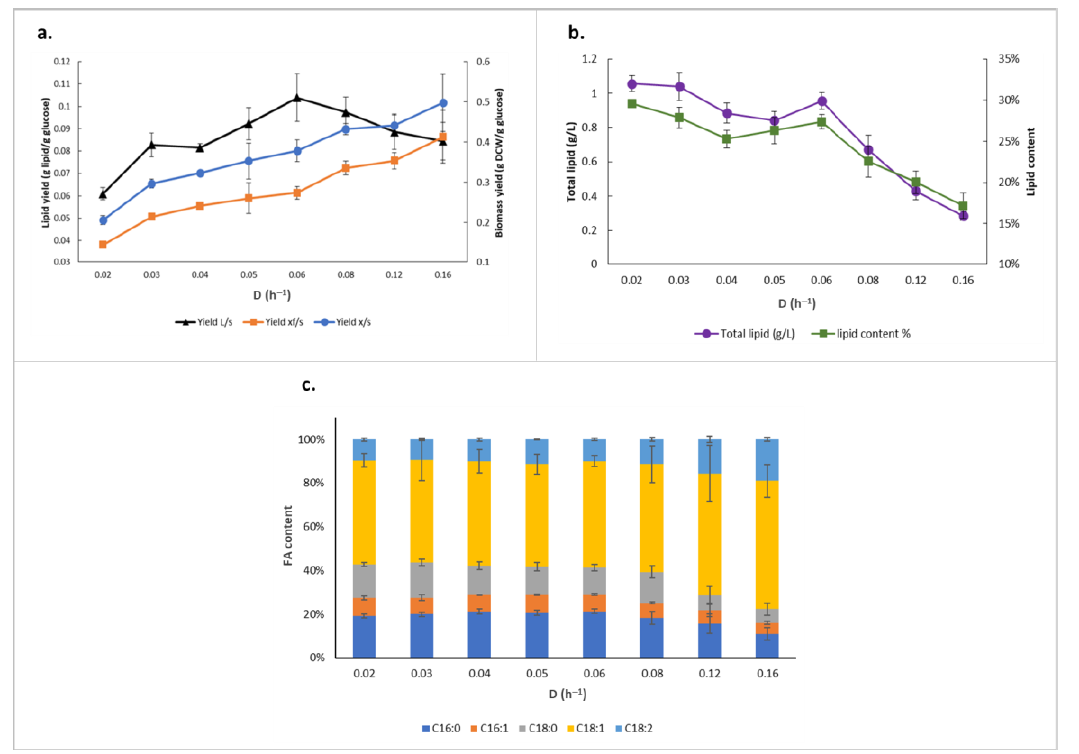
Figure 1. Lipid production profile of Y. lipolytica OKYL040 at different dilution rates. ( a ) Lipid and biomass yields (L: lipid, s: substrate which is glucose here, xf: non-lipid biomass, x: biomass); ( b ) total lipid production; ( c ) fatty acid (FA) composition.